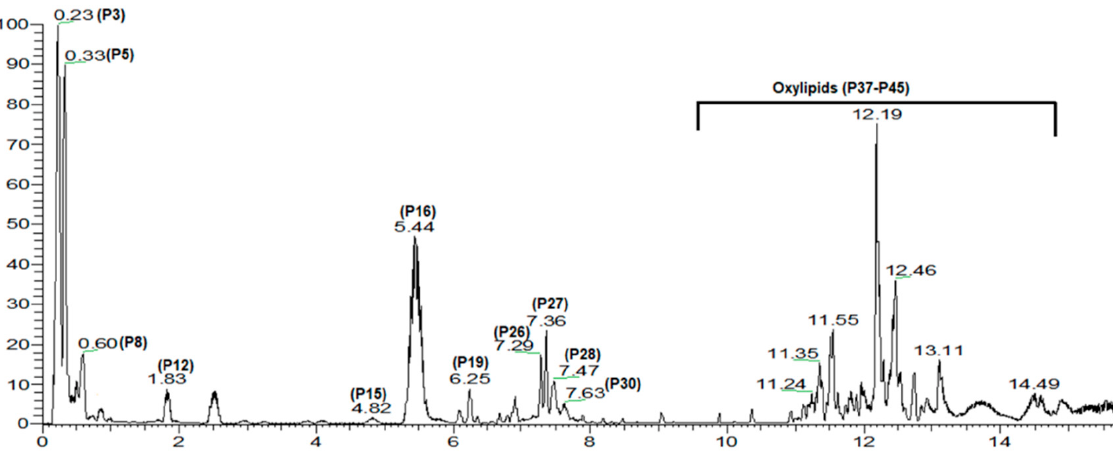
Figure 1. UPLC/MS total ion chromatogram (TIC) chromatogram of mango fruit methanol extract detected in negative ion mode with peaks numbering following that listed in Table 2.